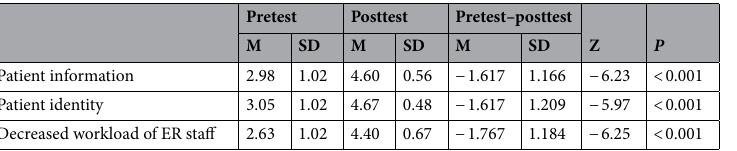
Table 5. Comparison of ER staff satisfaction before and after setting up the ER digital bedside